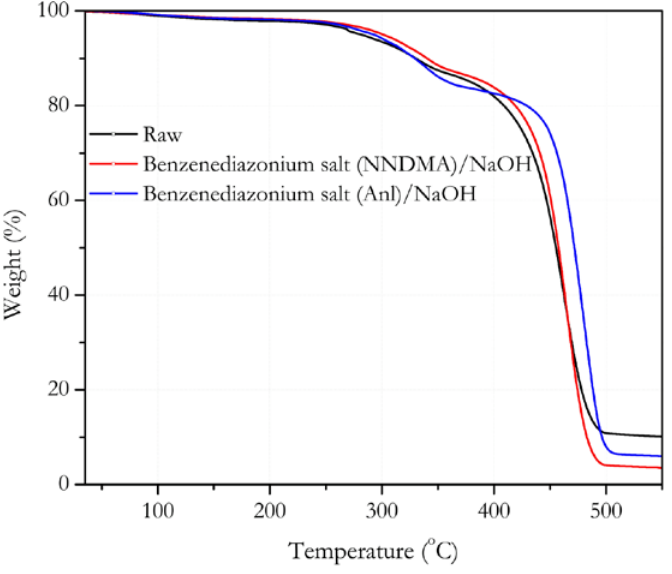
Figure 2: Weight of 35 wt% WH-PP composites as a function of